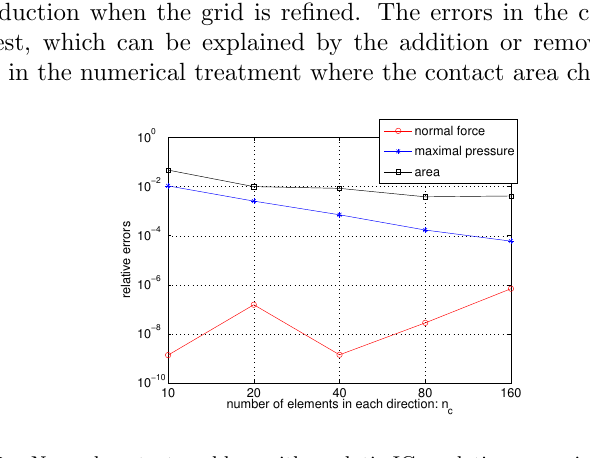
Figure 9. Normal contact problem with analytic ICs: relative errors in the normal force F z , in the maximal pressure p max and in the contact area. The horizontal axis shows the number of element in each direction of contact grid n c × n c .